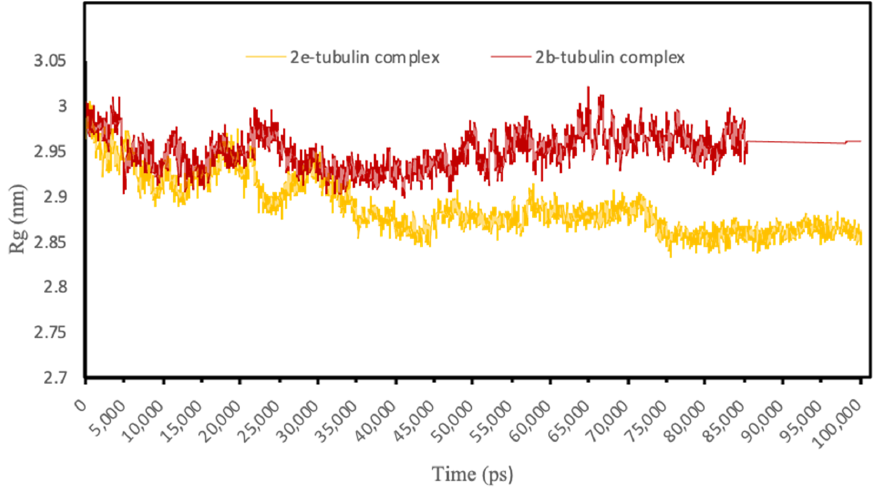
Figure 8. The radius of gyration plots for 2b-tubulin complex (red) and 2e-tubulin complex (yellow) for 100 ns of simulation trajectory at 300K